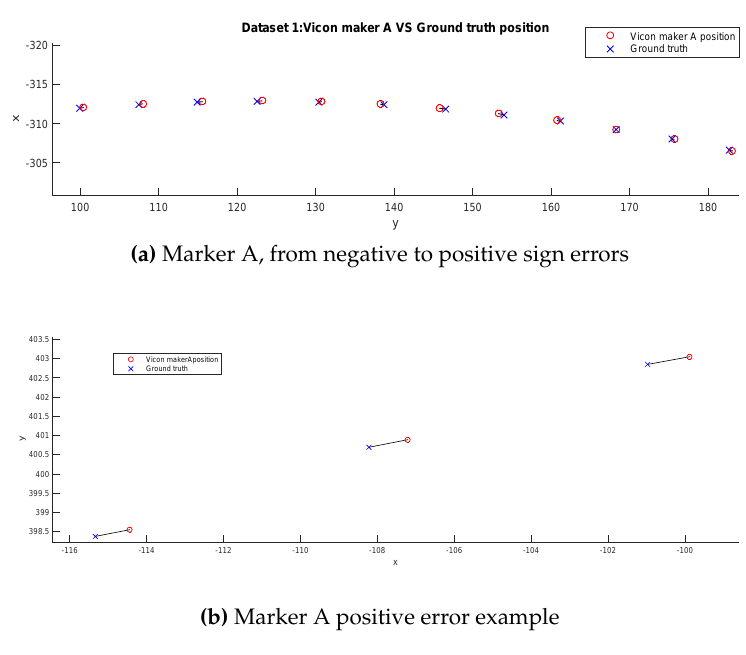
Figure 11. Planar errors, Dataset 1 (axis in